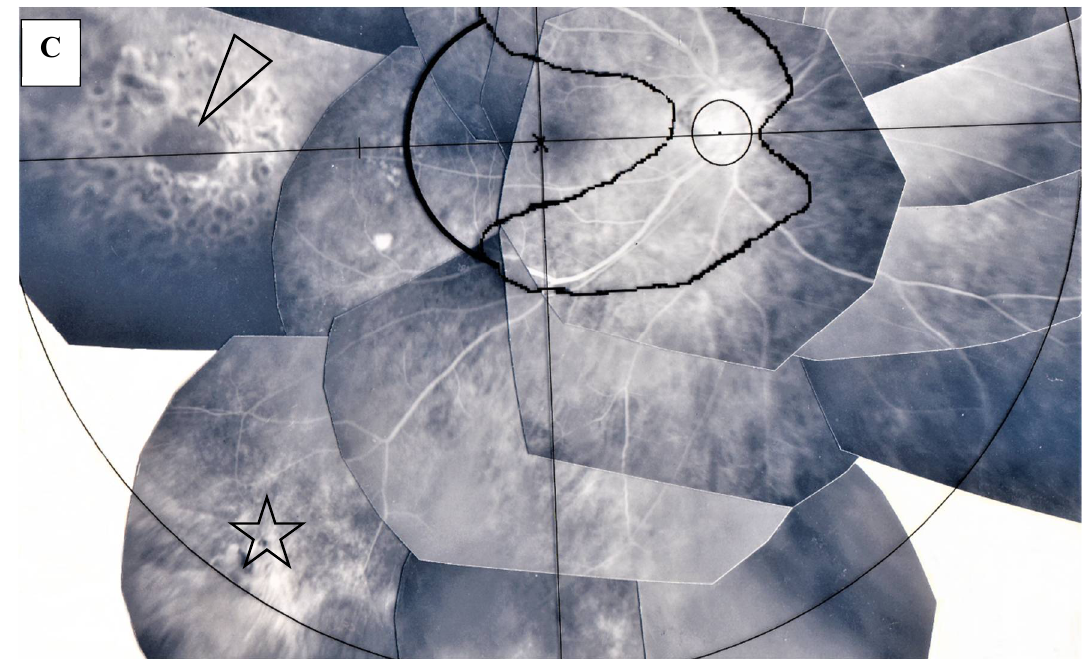
Figure 9. ( A ) Image of the right eye of Case 3, a 22-year-old male in Group I with a max IOP of 18 mmHg; ( B ) Image of the right eye of Case 12, a 22-year-old male in Group I with a max IOP of 15 mmHg; ( C ) Image of the right eye of Case 29, a 77-year-old male in Group II with a max IOP of 35mmHg. Photographs of FFA ( A , B ) and FFA mounted on a transparent sheet with different zones ( C ). Neovascularization (arrow in A ) and occlusion of the blood vessels (arrows in B ) were observed in the lattice-like degeneration (encircled area in A ) and adjacent to the retinal tear (arrowhead in B and B , inset), respectively. There was local retinal detachment with fluorescein staining of pigment epithelium ( B ). Retinal photocoagulation was performed for the retinal tear (arrowhead in C ) in the chorioretinal atrophy (star in C ).